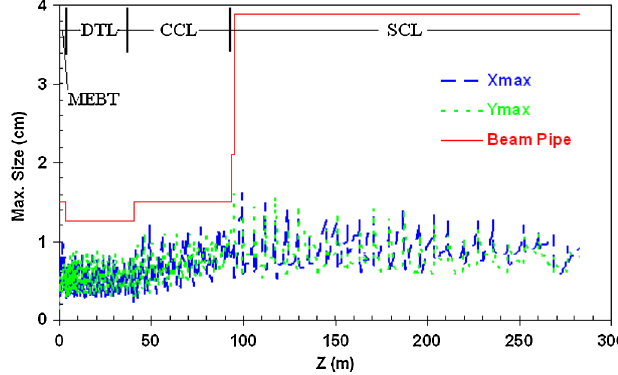
FIG. 4. (Color) Maximum beam emittance dilution versus trans- verse phase advance for the doublet lattice made up of identical quadrupoles with 30 and 10 unit dodecapoles.